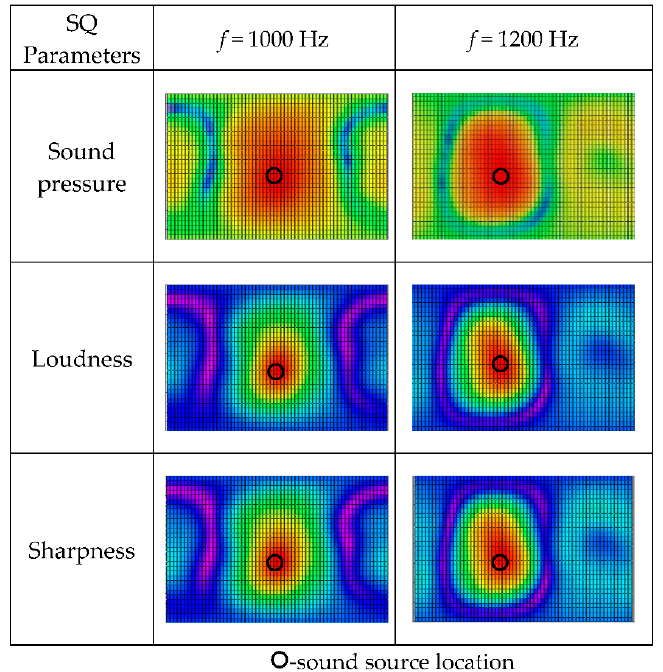
Figure 10. Spatial distributions of sound quality objective parameters for source reconstruction distance r = 0.1 m at different sound frequencies. (The results are shown in the form of plane expansion of the spherical calculation surface, and the horizontal axis is longitude: −π ~ π , the vertical axis is latitude: −π /2~ π /2).